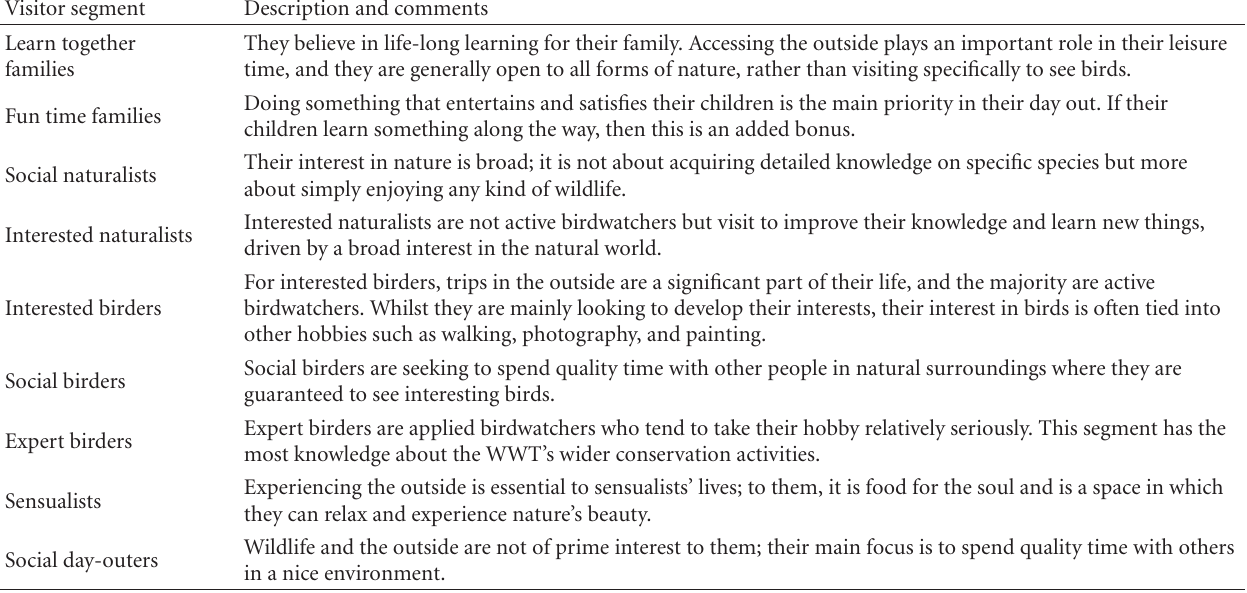
Table 2: Segmentation pen portraits—Modified and adapted from WWT visitor segmentation report